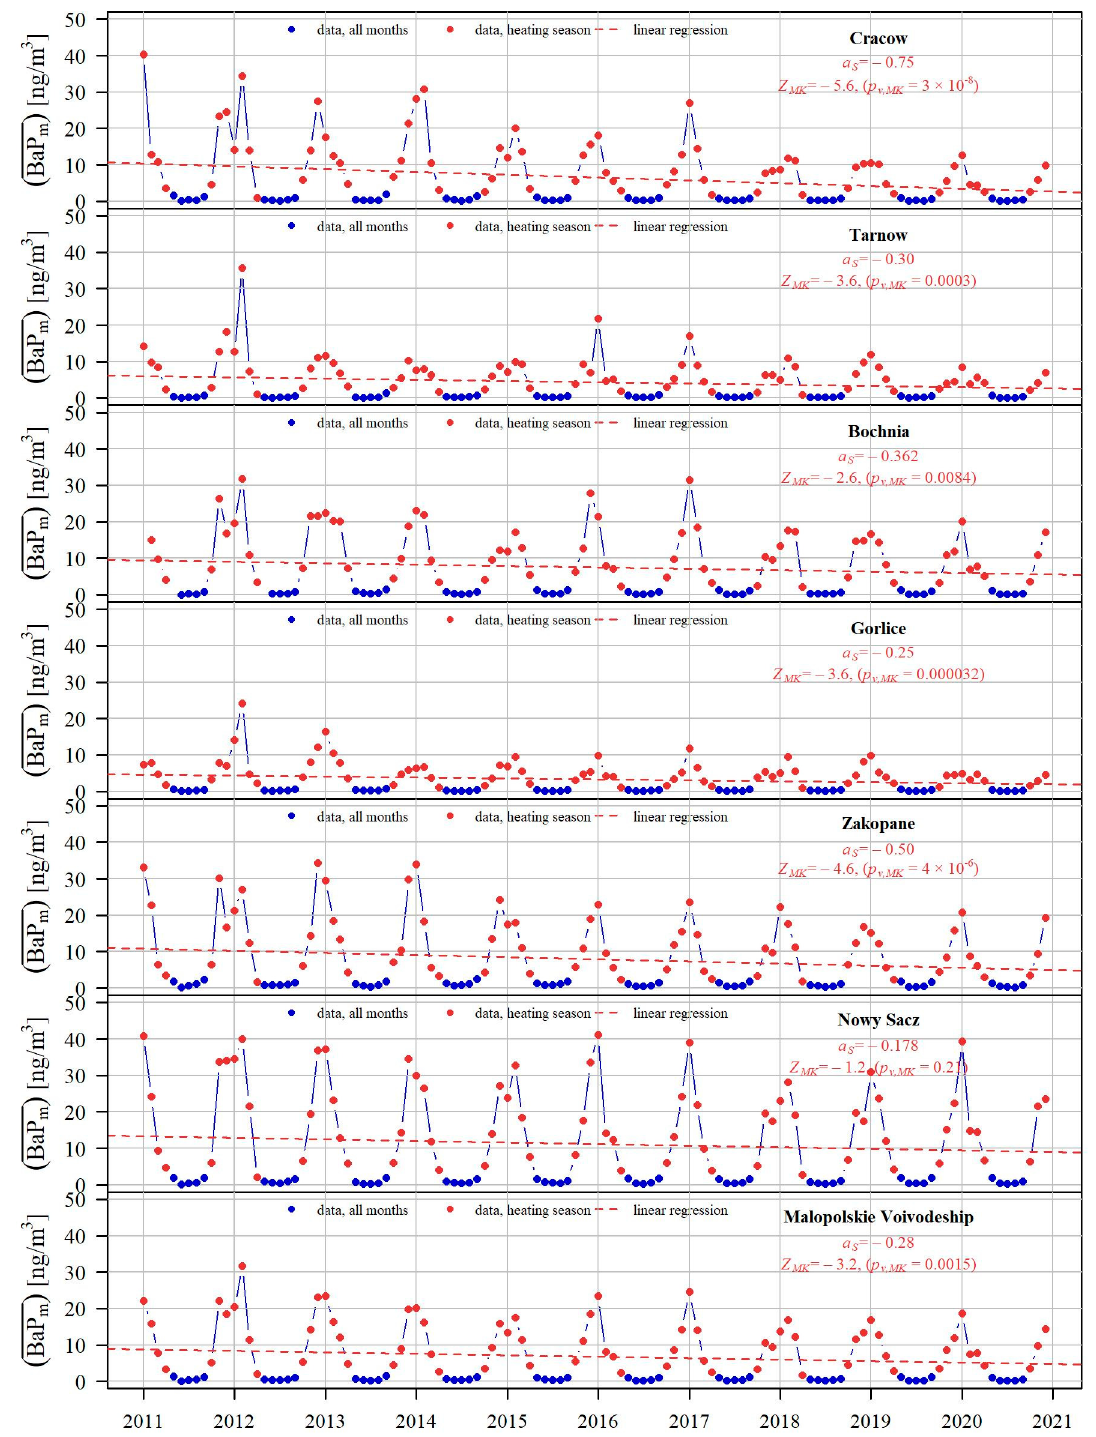
Figure 9. Distributions of average monthly concentrations of BaP m (PM10) in 2011–2020: for all months (blue points) and the heating season (red points). The symbol a TS means seasonality Sen’s slope [ n g/m 3 /year], while Z MK and p v , MK are the result of the seasonal Mann–Kendall test. Linear regressions (dotted lines) are shown for comparison. (Source: own elaboration based on the data from the database of the Chief Inspectorate for Environmental Protection [29]).